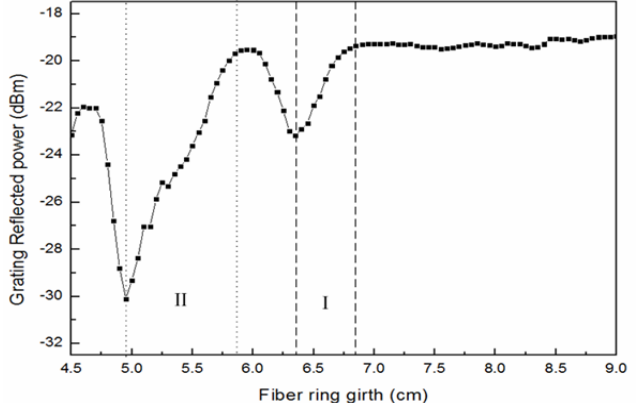
Figure 3. Changes in optical power for a fiber loop at various